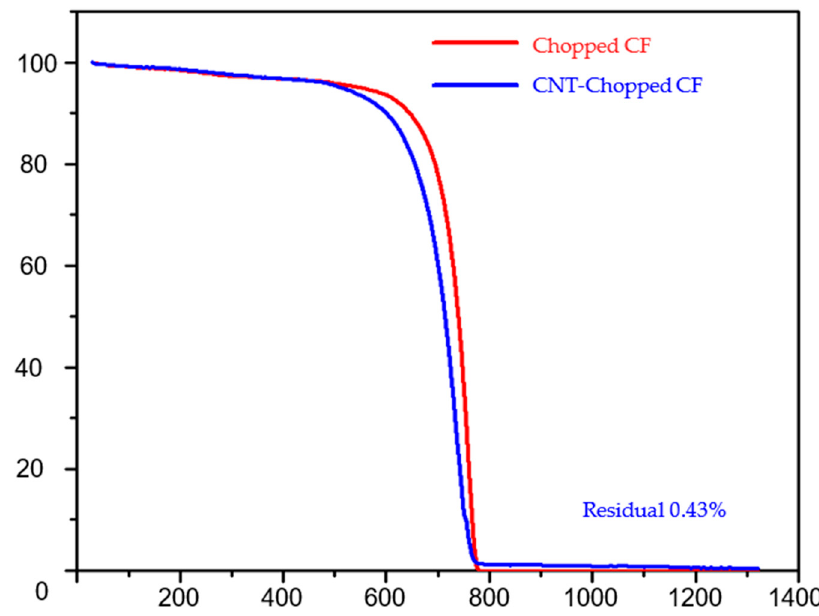
Figure 18. Thermogravimetric analysis graph for chopped carbon fiber and CNT-integrated